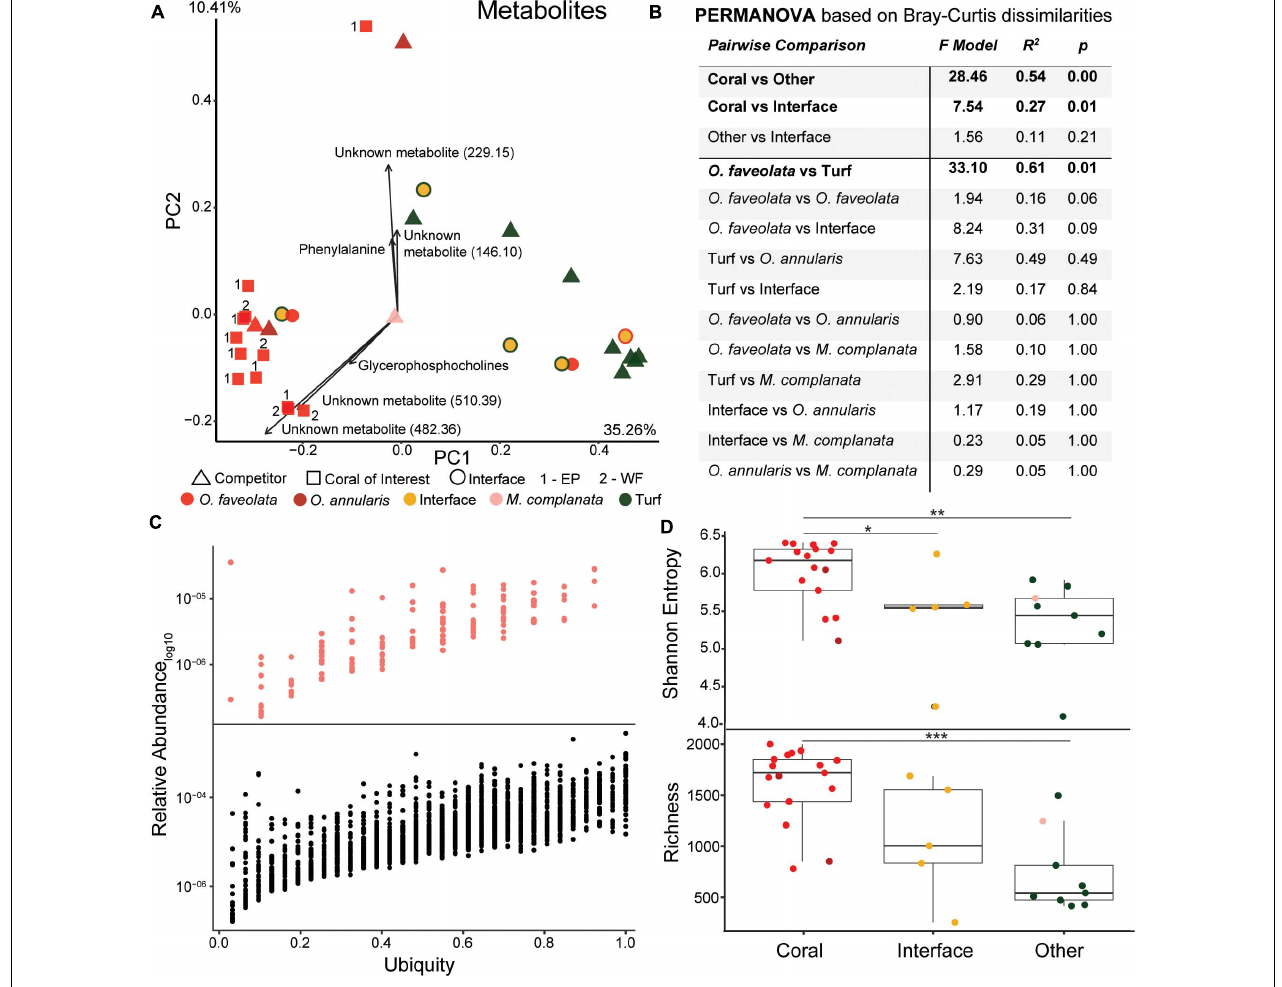
FIGURE 7 | Overview of metabolome data. (A) Principal components plot of the coral colonies of interest along with interfaces and their respective benthic competitors. Main driving metabolites shown along with mass to charge ratios for unknown metabolites. EP, East Point coral of interest; WF, Water Factory coral of interest. (B) PERMANOVA results based on Bray-Curtis dissimilarities. (C) Relative abundance versus ubiquity of each metabolite from all samples (bottom plot) and those unique to Orbicella faveolata samples (top plot). Ubiquity for unique O. faveolata metabolites is normalized to total O. faveolata samples. (D) Diversity